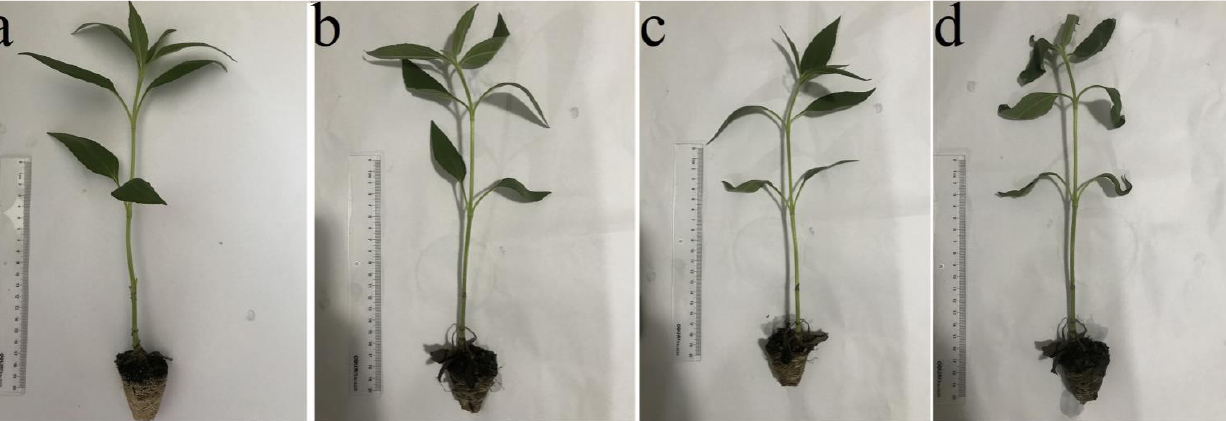
Figure 2. The morphology of Jerusalem Artichokes treated with drought stress, and the heatmap of correlation and prin- cipal component analysis (PCA) between different drought treatment and quality control (QC) samples. ( a ) 0 h; ( b ) 18 h; ( c ) 24 h; ( d ) 36 h; ( e ) Principal component analysis. ( f ) Heatmap of correlation. 2.2. Qualitative and Quantitative Metabolites To ensure the repeatability of samples under drought stress at different times, quality control (QC) samples were inserted in every 10 test samples during the analysis [29]. The overlapping map of total ion current (TIC) and different QC samples showed that the curve overlap of total ion flow was high and the retention time and peak intensity were the same, which indicates that the signal stability for the same sample was better when the mass spectrometry was detected at different times (Figure S1). The qualitative and quantitative mass spectrometry analysis of metabolites in differ- ent drought stress samples were based on the Kyoto Encyclopedia of Genes and Genomes (KEGG) compound database, MetWare database (MWDB), and multiple reaction moni- toring (MRM). A total of 661 metabolites were obtained using widely targeted metabolic analysis (Table S1). The classification of secondary substances showed that there were 28 groups, including 127 phenolic acids, 77 amino acids and derivatives, 60 organic acids, 45 nucleotides and derivatives, 41 free-fatty acids, 41 flavonoid, 37 saccharides and alcohols, 36 flavonols, 28 glycerol esters, 21 lysophosphatidylcholine, 14 isoflavones, 13 vitamins, 12 lysophosphatidylethanolamine, 12 sesquiterpenoids, nine triterpene, seven alkaloids,